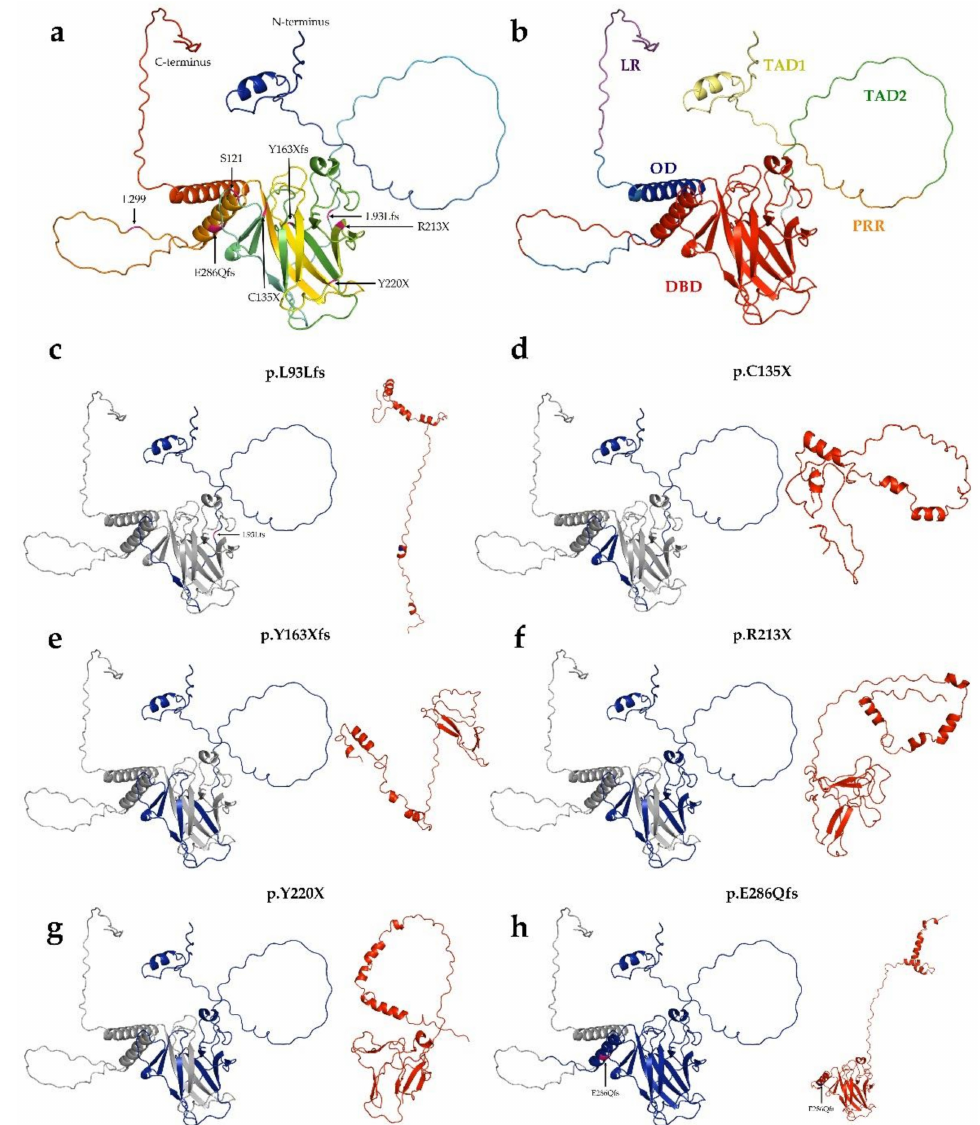
Figure 3. Structure of p53 Robetta prediction of truncated proteins. ( a ): Tertiary structure of wild- type p53 protein. The structure was generated by AlphaFold. ( b ): Overall structure and domain organization of wild-type p53. ( c – h ): The wild-type protein was colored blue for the length of its aligned mutant-type (red) counterpart. ( c ): p.L93Lfs (121 AA) protein, ( d ): p.C135X (134 AA), ( e ): p.Y163Xfs (162 AA), ( f ): p.R213X (212 AA), ( g ): Y220X (219 AA), ( h ): p.E286Qfs (299